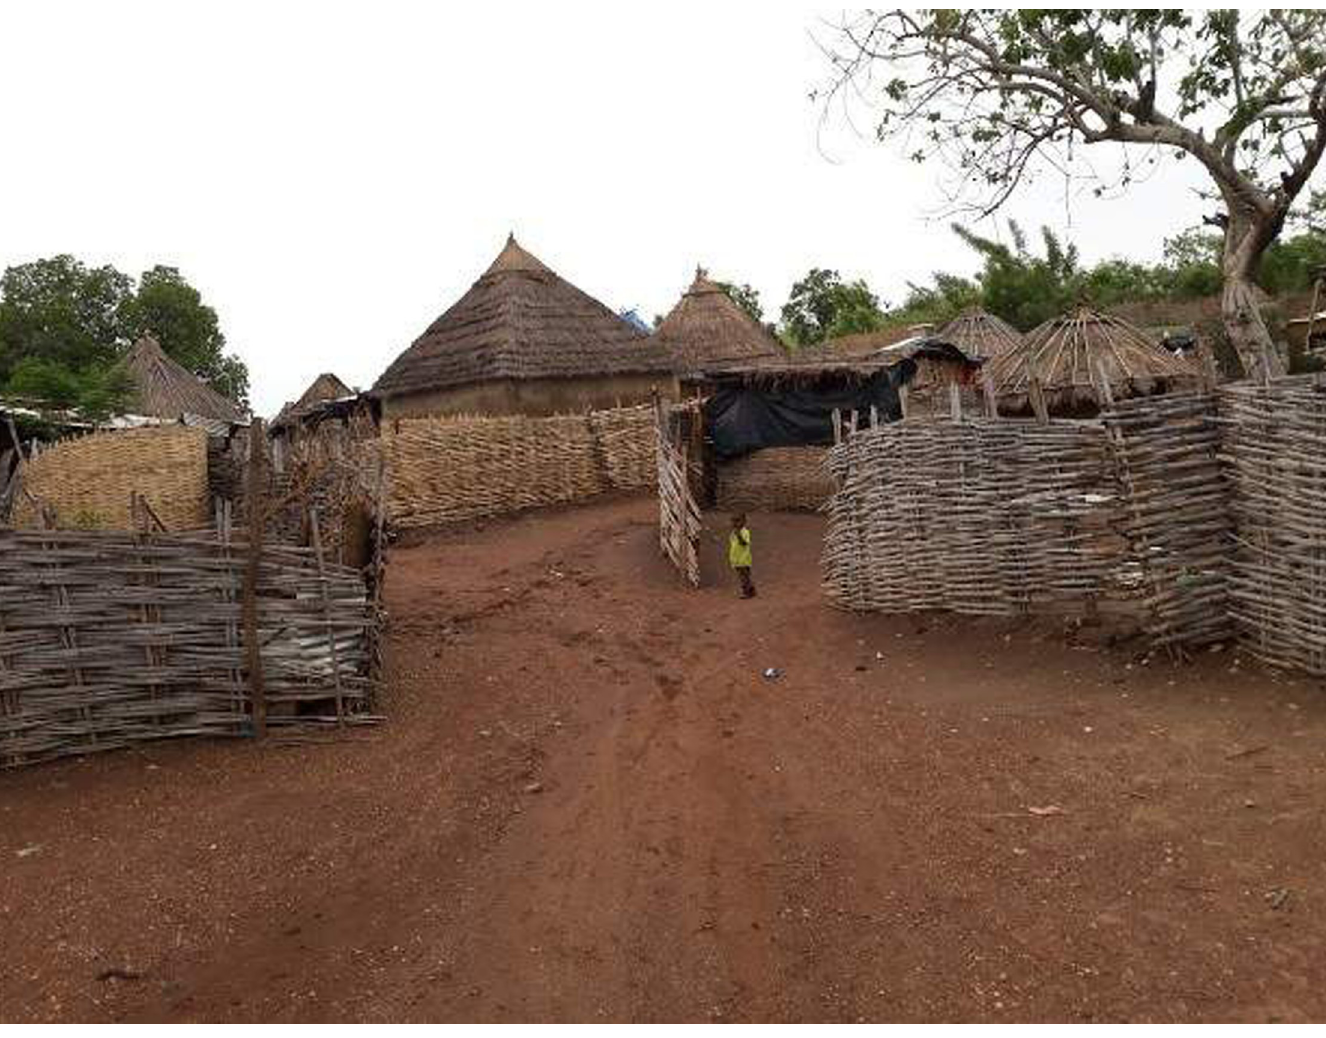
Fig 3. Picture of a household in Saraya